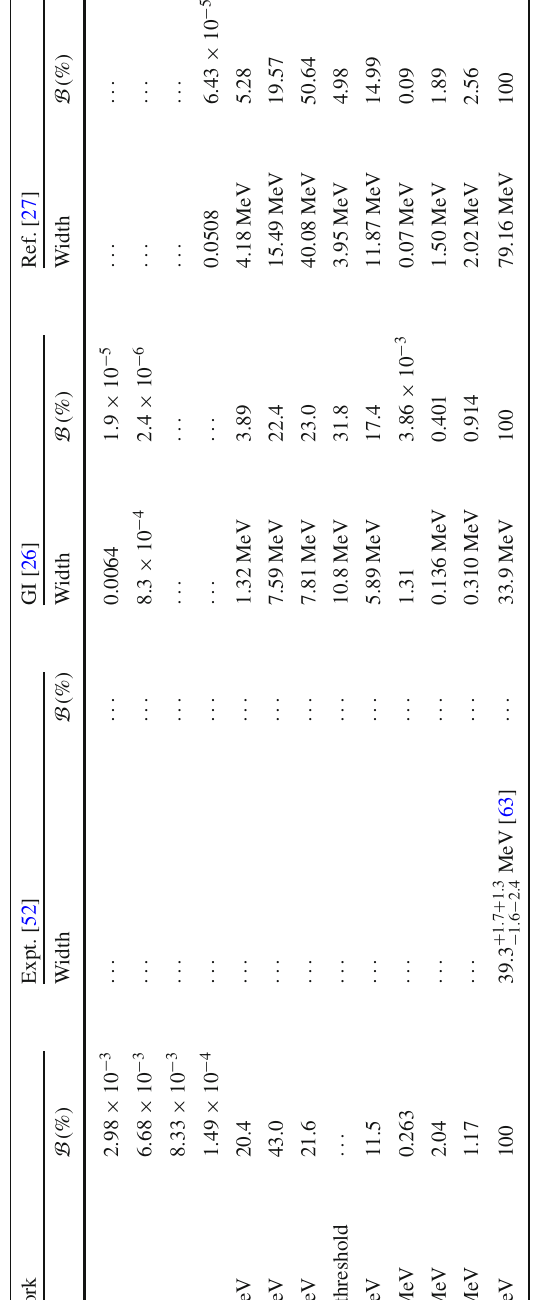
¯ b system, we obtain γ = 7 . 09 with